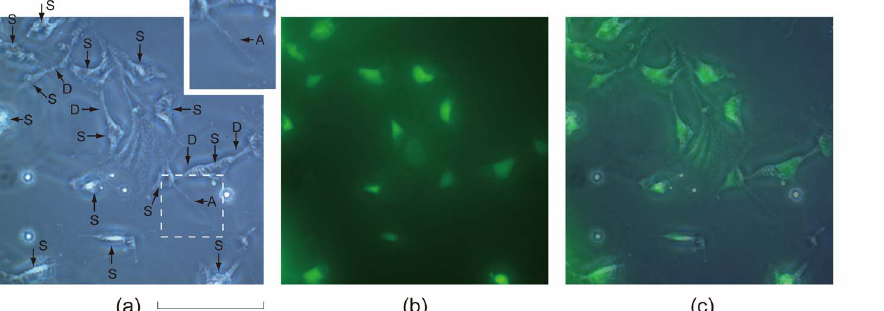
Fig. 2 (a) Phase contrast photograph, (b) fluorescent one, and (c) merged one of (a) and (b) of cultured neurons over P(VDF-TrFE) film modified by fibronectin and fabricated on glass substrate. Symbols A, D, and S indicate axon, dendrite, and soma, respectively. Inset in (a) is enlarged view around axon of A.